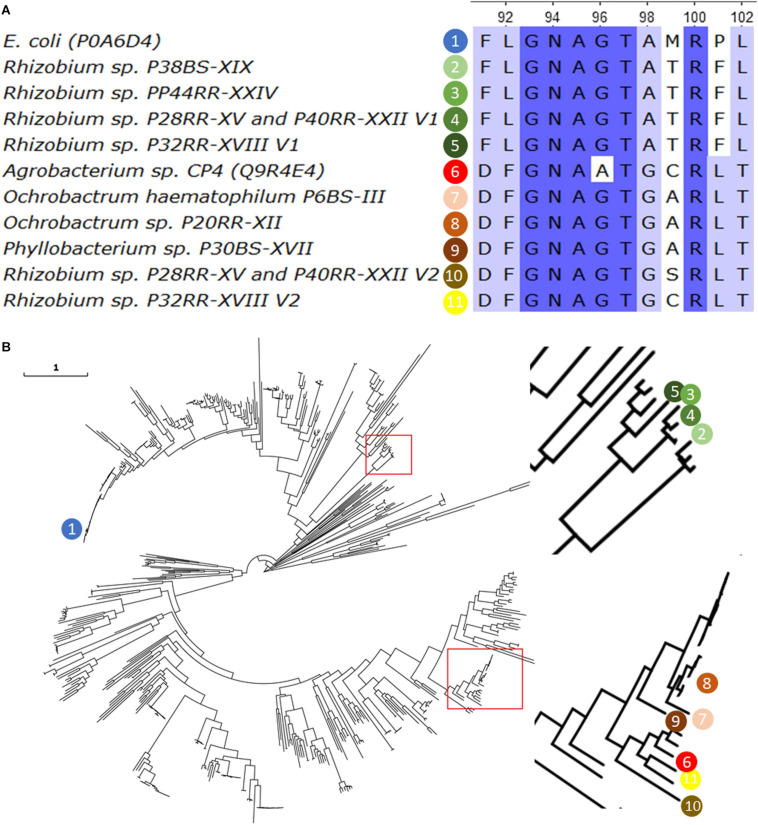
The Sequence of the 5-enolpyruvylshikimate-3-phosphate synthase (EPSPS, EC2.5.1.19) found in the fully sequenced genomes was aligned using the ClustalW algorithm, together with the most representative Class I (E. coli) and Class II (Agrobacterium CP4) enzymes. A fragment of twelve amino acids from position 91 to 102 (according to E. coli sequence) and including the 101 position is presented (A). A phylogenetic tree was build using 589 EPSPS reviewed sequences from UniProt (www.unirpot.org) and those found in the investigated genomes. Sequences were aligned using ClustalO v1.2.4, and the Maximum-Likelihood phylogenetic tree were calculated using IQ-Tree v1.6.12 selecting the best substitution model based on BIC score with the option -m TEST. Confidence levels for individual branches were determined by ultrafast bootstrap approximation with 10000 replicates. The image was magnified in those branches where the sequences of interest are located, which are indicated in numbered colored spheres (B). The EPSPS sequence of O. haematophilum P6BS-III was included in the analysis for comparative reasons.